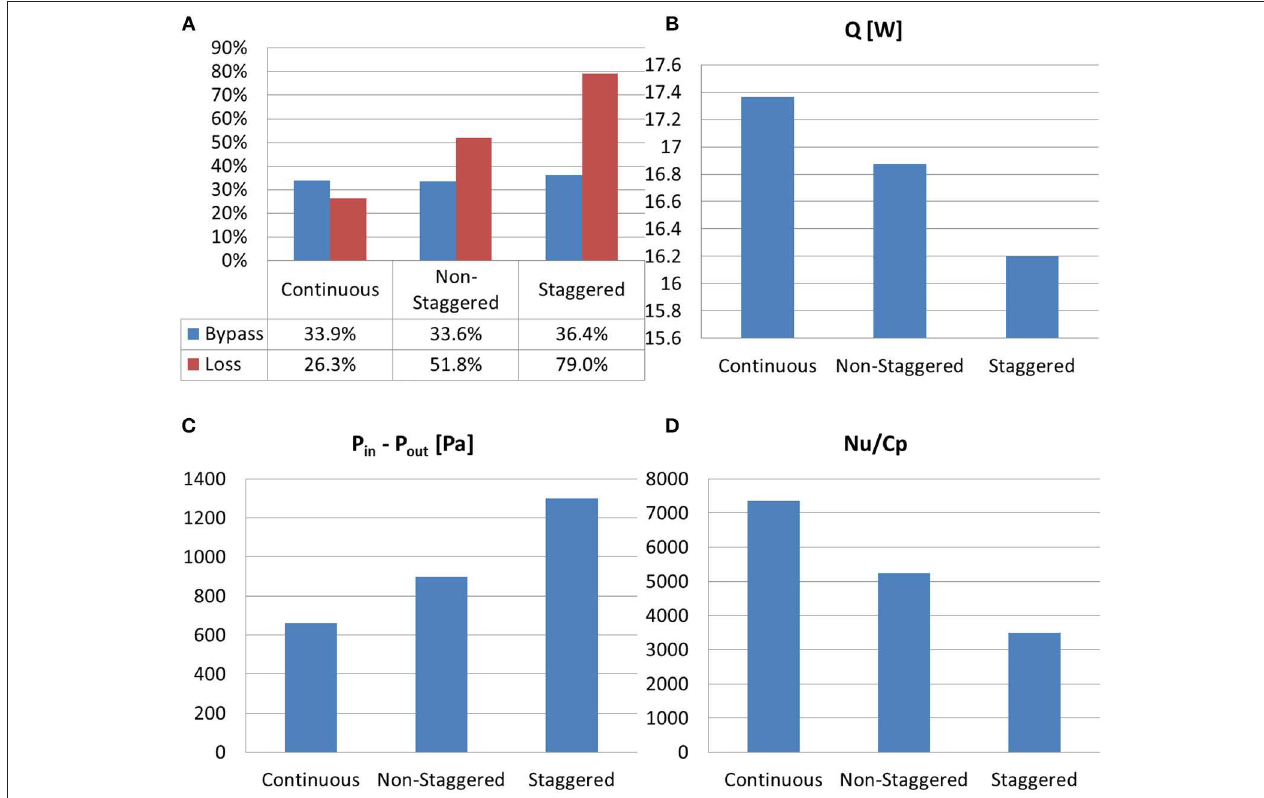
FIGURE 13 | Continuous (case 4) vs. segmented (staggered and non-staggered) fins. (A) Bypass and loss. (B) Heat-transfer rate (Q) through the fins. (C) Pressure drop ( 1 P). (D) Nu/Cp.